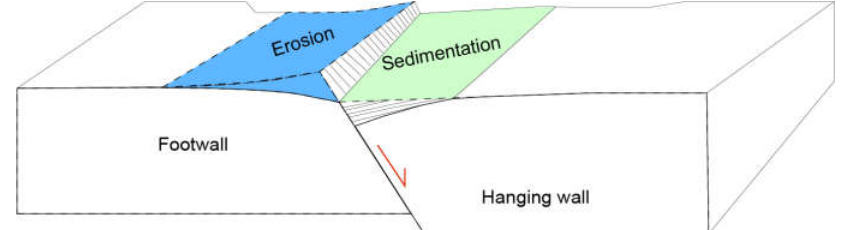
Figure 16. Symbolic erosion-sedimentation model on the footwall and hanging wall of normal fault. Sediments are deposited on the hanging wall of a normal fault in response to footwall erosion. Typically, syn-kinematic wedge sedimentation geometry is also observed in these fault zones (Figure 12).